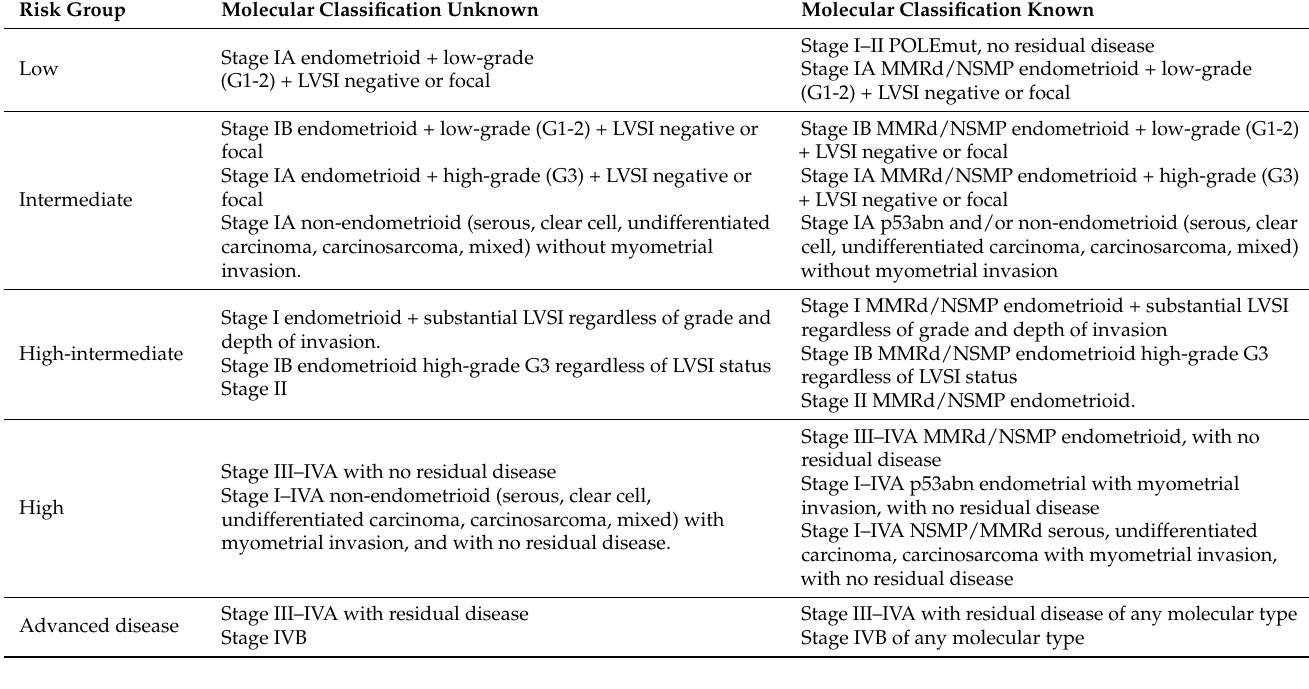
Table 1. Definition of prognostic risk groups, Concin N, et al. Int J Gynecol Cancer